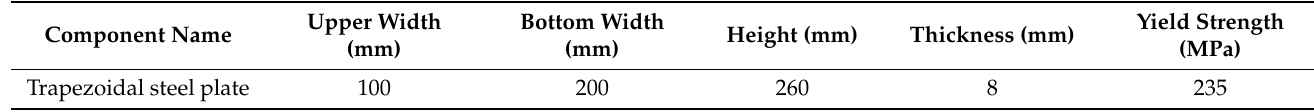
Table 2. Trapezoidal steel plate size (mm).